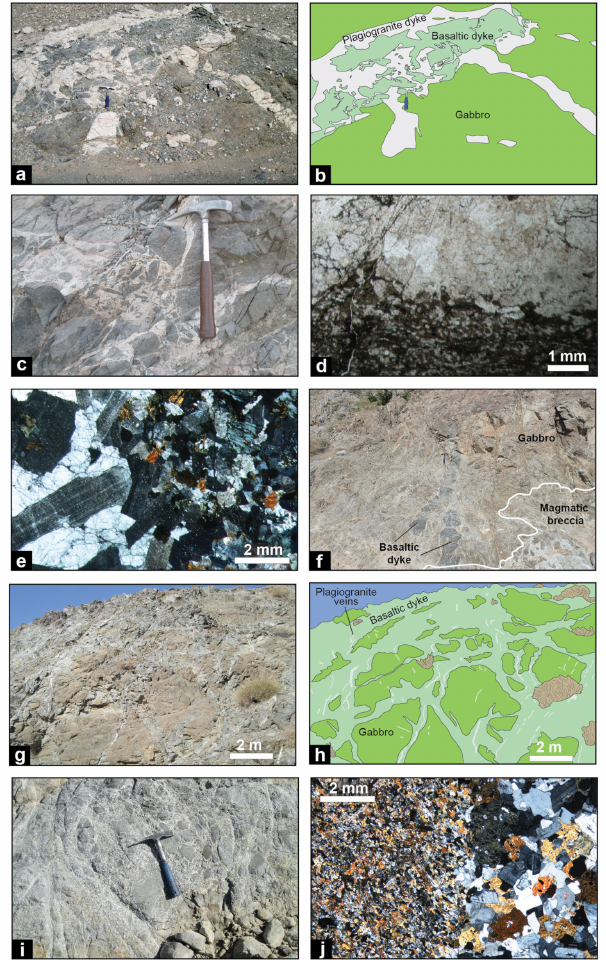
Figure 4. Field occurrence and photomicrographs of the sections sampled for zircon dating. ( a – e ) Chah Mirak section: ( a ) view and ( b ) schematic sketch of the complex intrusive relationships between isotropic gabbro, mafic dyke, and plagiogranite dyke (hammer for scale). ( c ) Magmatic breccia showing plagiogranite matrix enclosing sub-angular to rounded clasts of both gabbro and mafic dyke (hammer for scale), ( d ) photomicrographs of the contact between matrix and clasts in the magmatic breccia, ( e ) photomicrographs of the curviplanar contact between the plagiogranite and the gabbro. ( f – j ) Bandkouh section: ( f ) view and ( g ) schematic explanatory drawing of the transition zone between the isotropic gabbro and the sheeted dyke showing a network of basaltic dykes crosscutting the gabbro screen. White plagiogranite veinlets crosscut both the gabbro and the dykes, ( h ) magmatic breccia bodies within the gabbro (hammer for scale), ( i ) close-up view of the magmatic breccia showing sub-angular to rounded clasts set within plagiogranite matrix. Plagiogranite veinlets are injected in the clasts from the matrix (hammer for scale), ( j ) gradual intrusive contact between plagiogranite matrix and micro-gabbro clasts in the magmatic